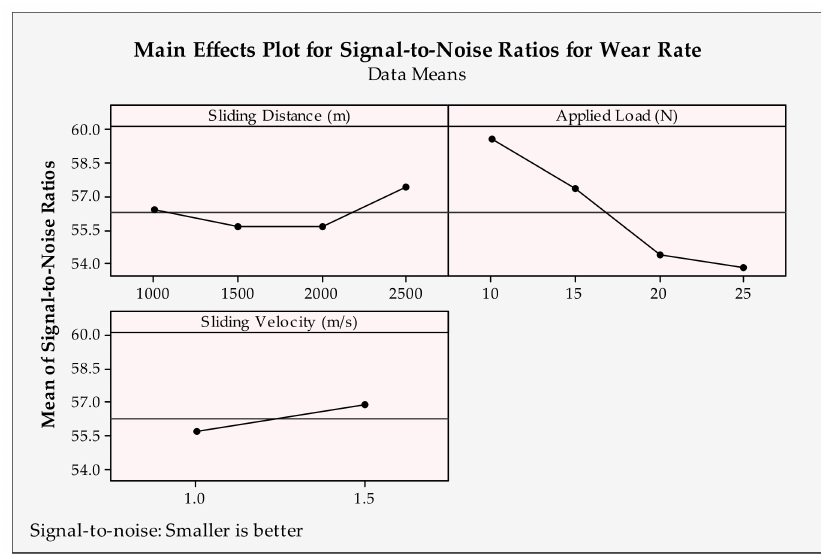
Figure 8. Signal-to-noise ratios of wear rate for tribological